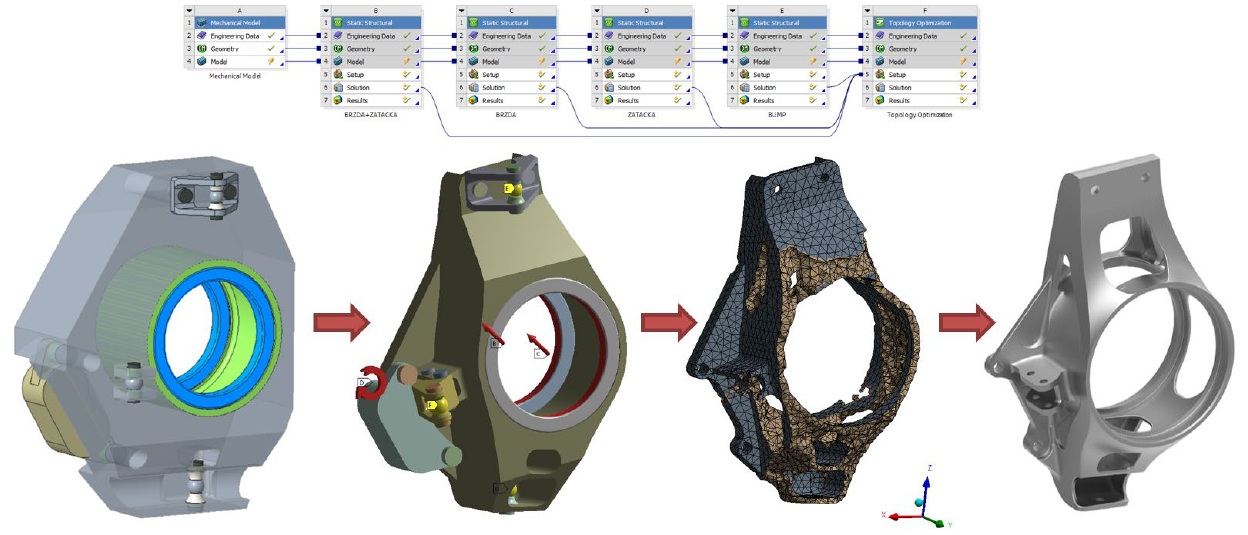
Figure 1. Topological optimization workflow.